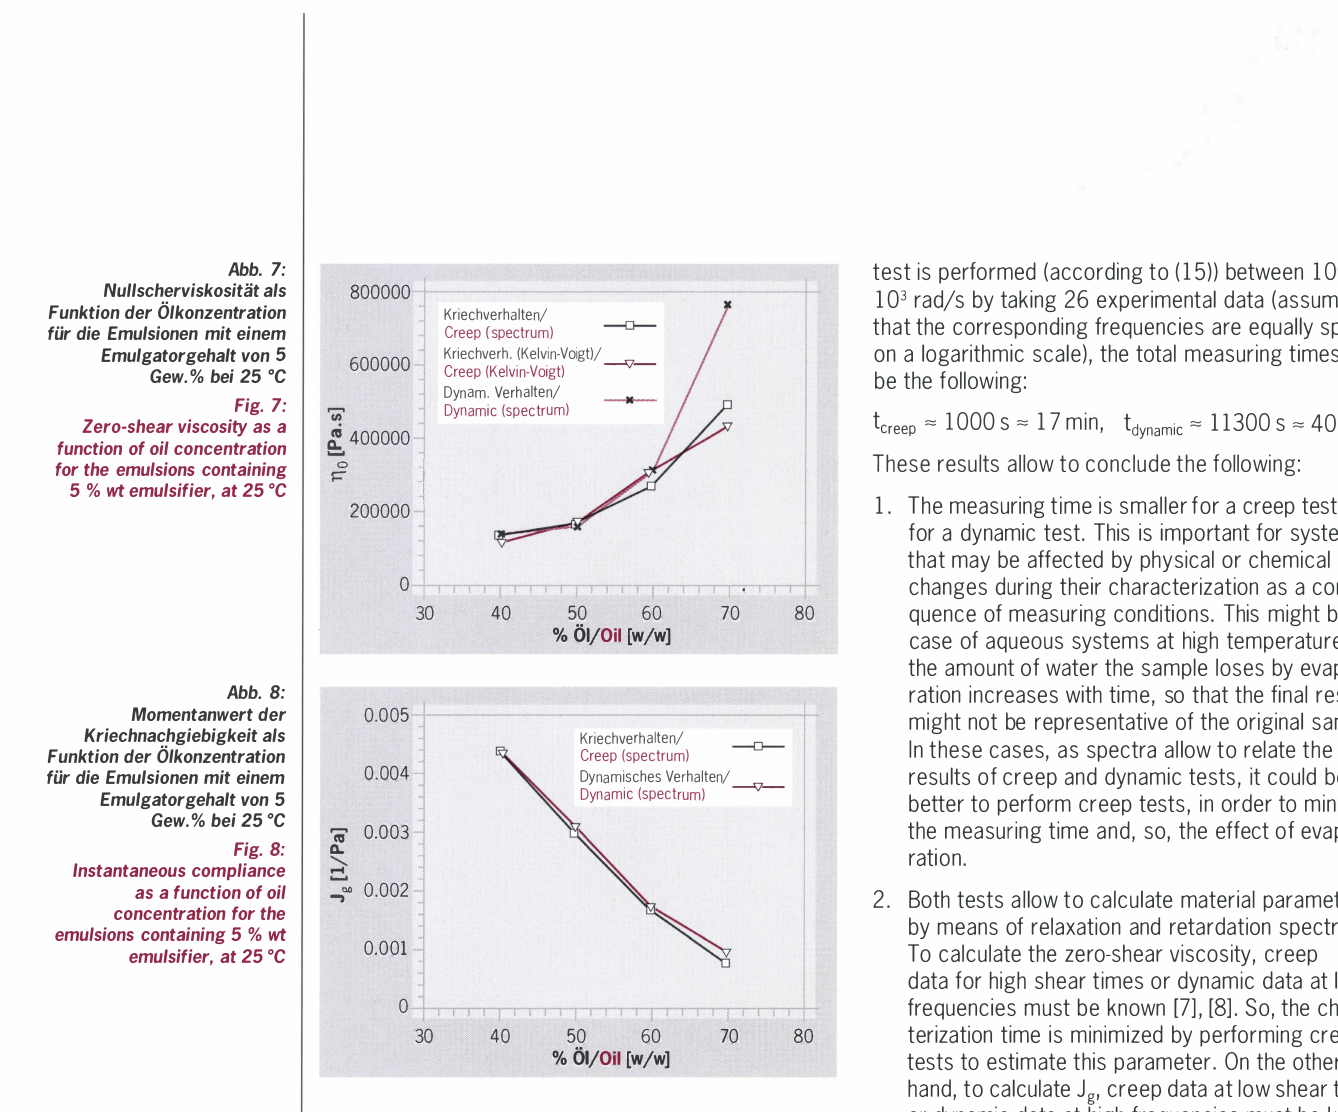
Abb. 8: Momentanwert der Kriechnachgiebigkeit als Funktion der O lkonzentration fur die Emulsionen mit einem Emulgatorgehalt von 5 Gew.% bei 25 oc Fig. 8: Instantaneous compliance as a function of oil concentration for the emulsions containing 5 % wt emulsifier, at 25